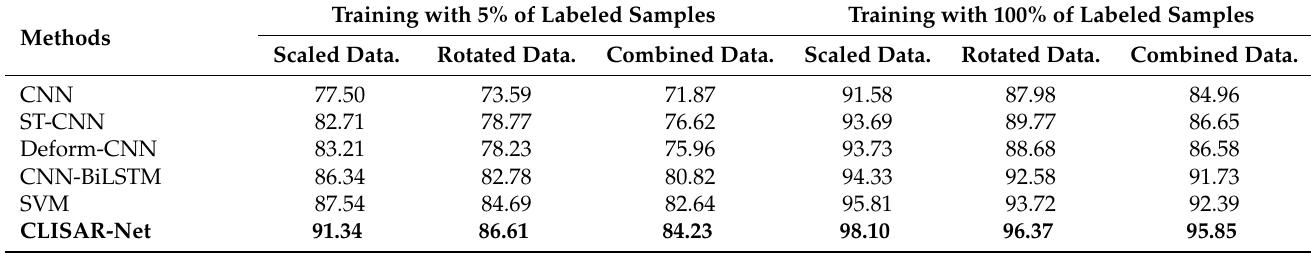
Table 4. Classification accuracy (%) of CLISAR-Net and other methods using 5% and 100% of labeled training samples on the three